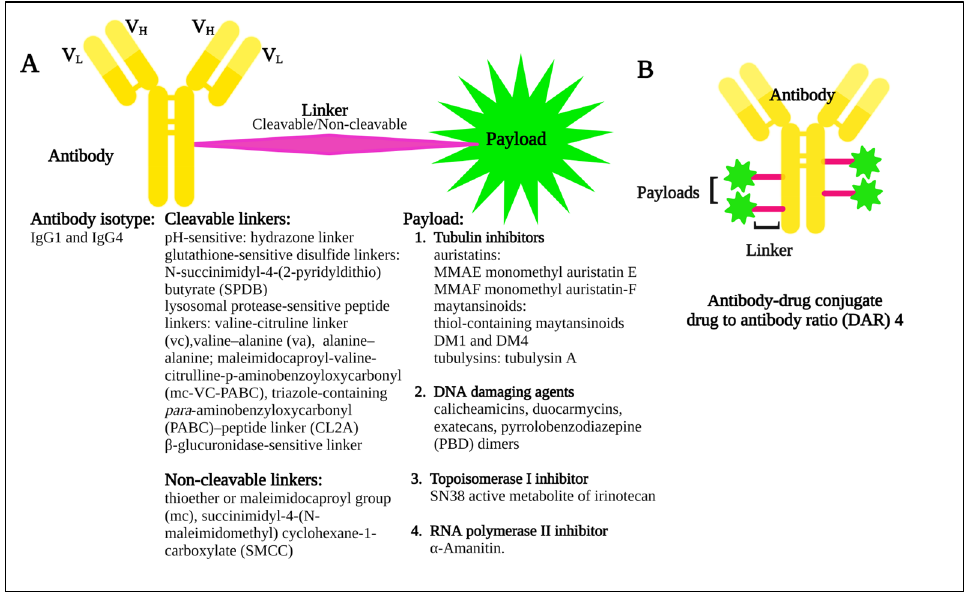
Figure 2. ( A ) Diagram showing the basic components of an antibody–drug conjugate, including some of the possible linker and payload combinations. ( B ) Model structure of an antibody–drug conjugate with a drug to antibody ratio of 4.